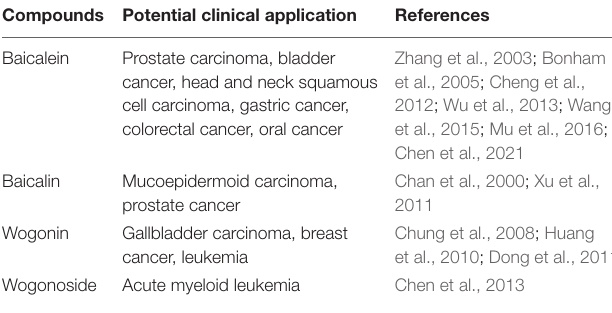
TABLE 1 | The antitumor activities of 4 (cid:48) -deoxyRSFs from Scutellaria baicalensis